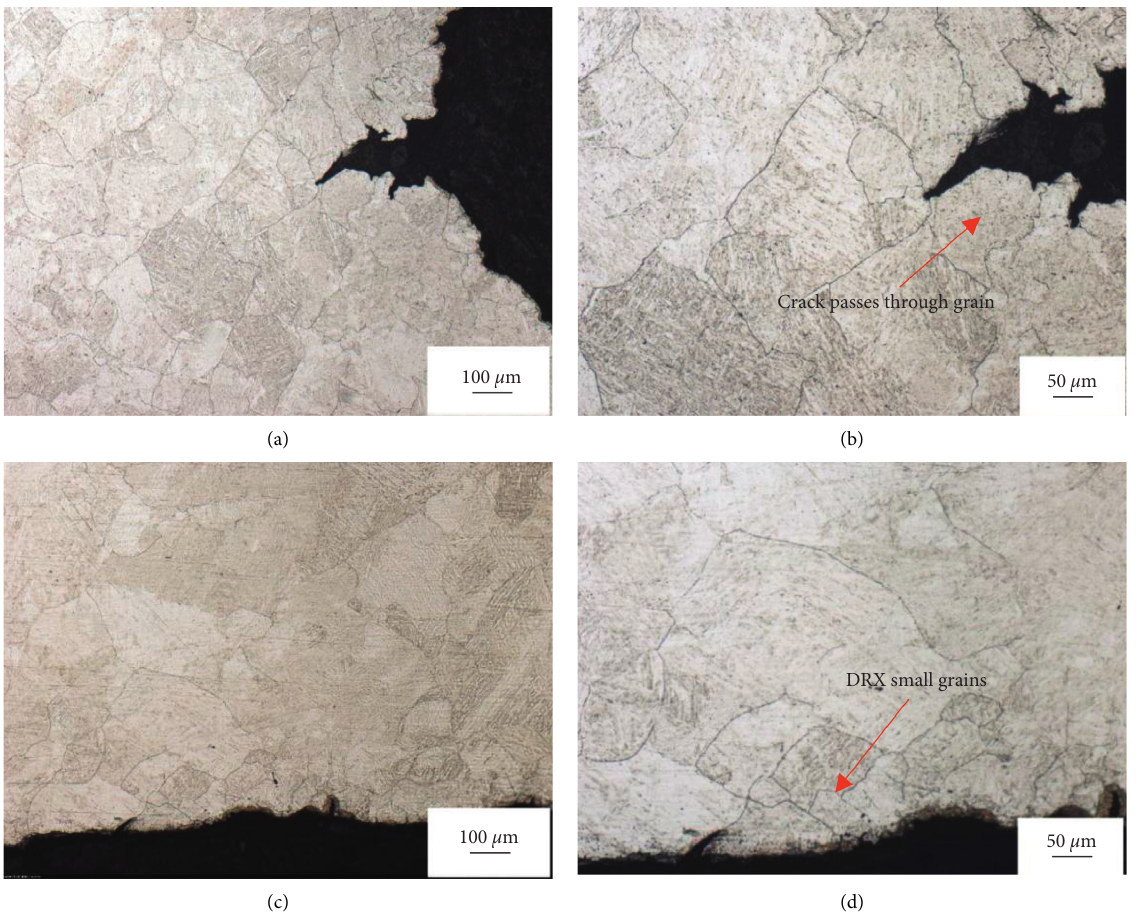
Figure 4: Microstructure of the crack healing zone at FR 1.1. (a, c) 100 times magnification. (b, d) 200 times